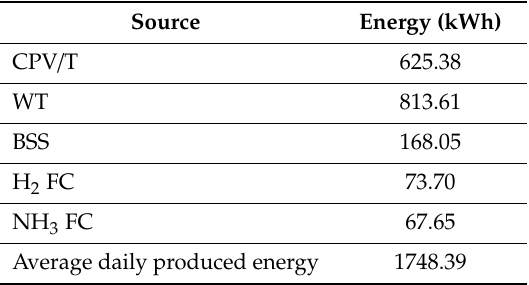
Table 6. Average daily EV charging energy by